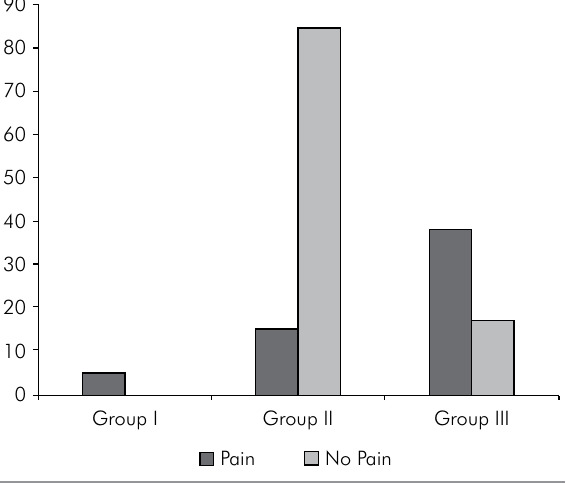
Figure 2. RDC/TMD division groups and pain